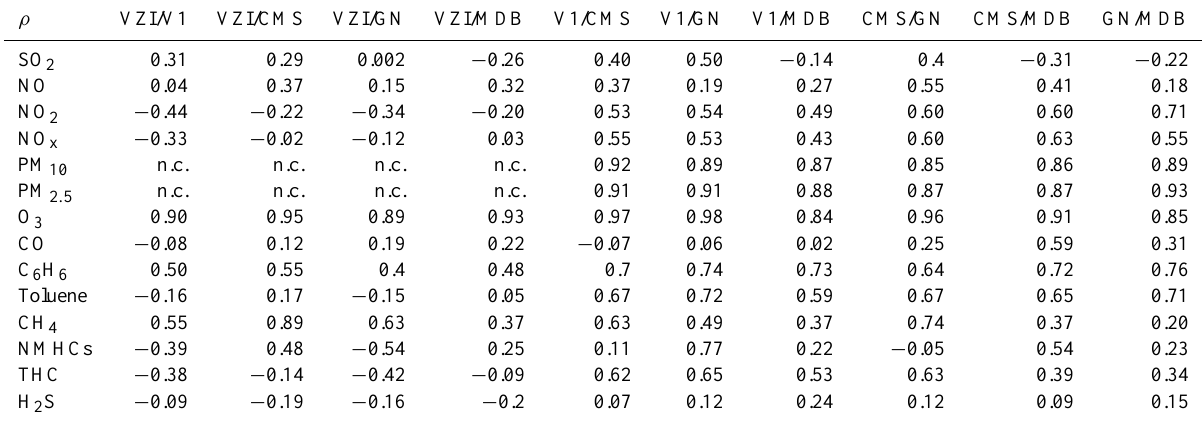
Table 5. Pearson correlation coefficients ( ρ) calculated for each pollutant and each pair of stations. Legend: n.c. – not